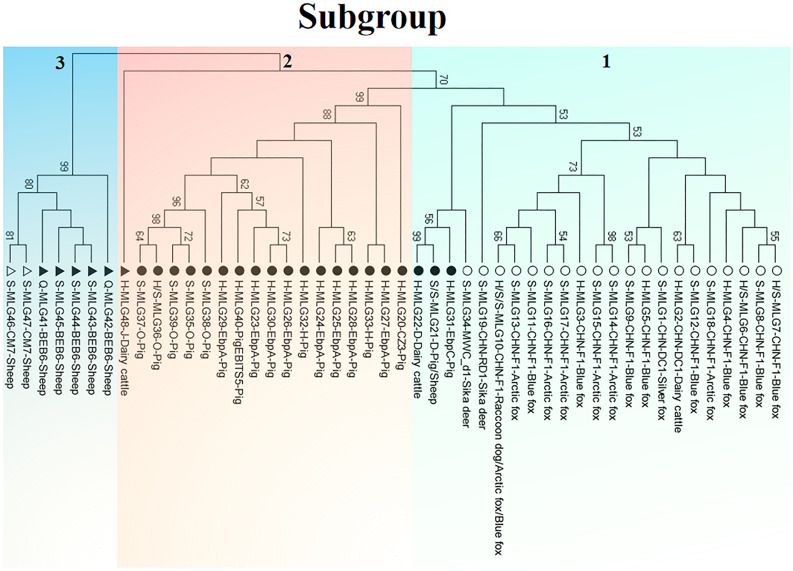
Phylogenetic relationship of multilocus genotypes (MLGs) of animal-derived E. bieneusi isolates. The relationship was inferred by a neighbor-joining analysis of 48 concatenated nucleotide sequences of the five genetic loci (ITS, MS1, MS3, MS4, MS7) from 90 E. bieneusi isolates belonging to 14 ITS genotypes (CHN-DC1, CHN-F1, CHN-RD1, CZ3, D, EbpA, CHN-RD1, CZ3, D, EbpA, PigEBITS5, BEB6, CM7, and J) from dairy cattle, pigs, sheep, sika deer, blue foxes, arctic foxes, a silver fox, and a raccoon dog (Supplementary Table S4) based on genetic distance by the Kimura 2-parameter model. Each sequence is identified by its sampling site (H: Harbin; Q: Qiqihar; S: Suihua), MLG designation and ITS genotype as well as host origin. The solid and open circles/triangles indicate zoonotic and host-adapted ITS genotypes, respectively, with circle and triangle ones belonging to ITS group 1 and ITS group 2, respectively.